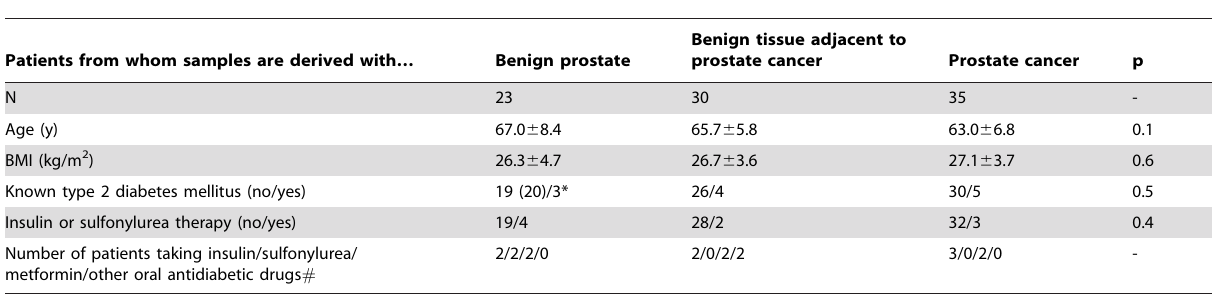
Table 1. Clinical characteristics of the patients.